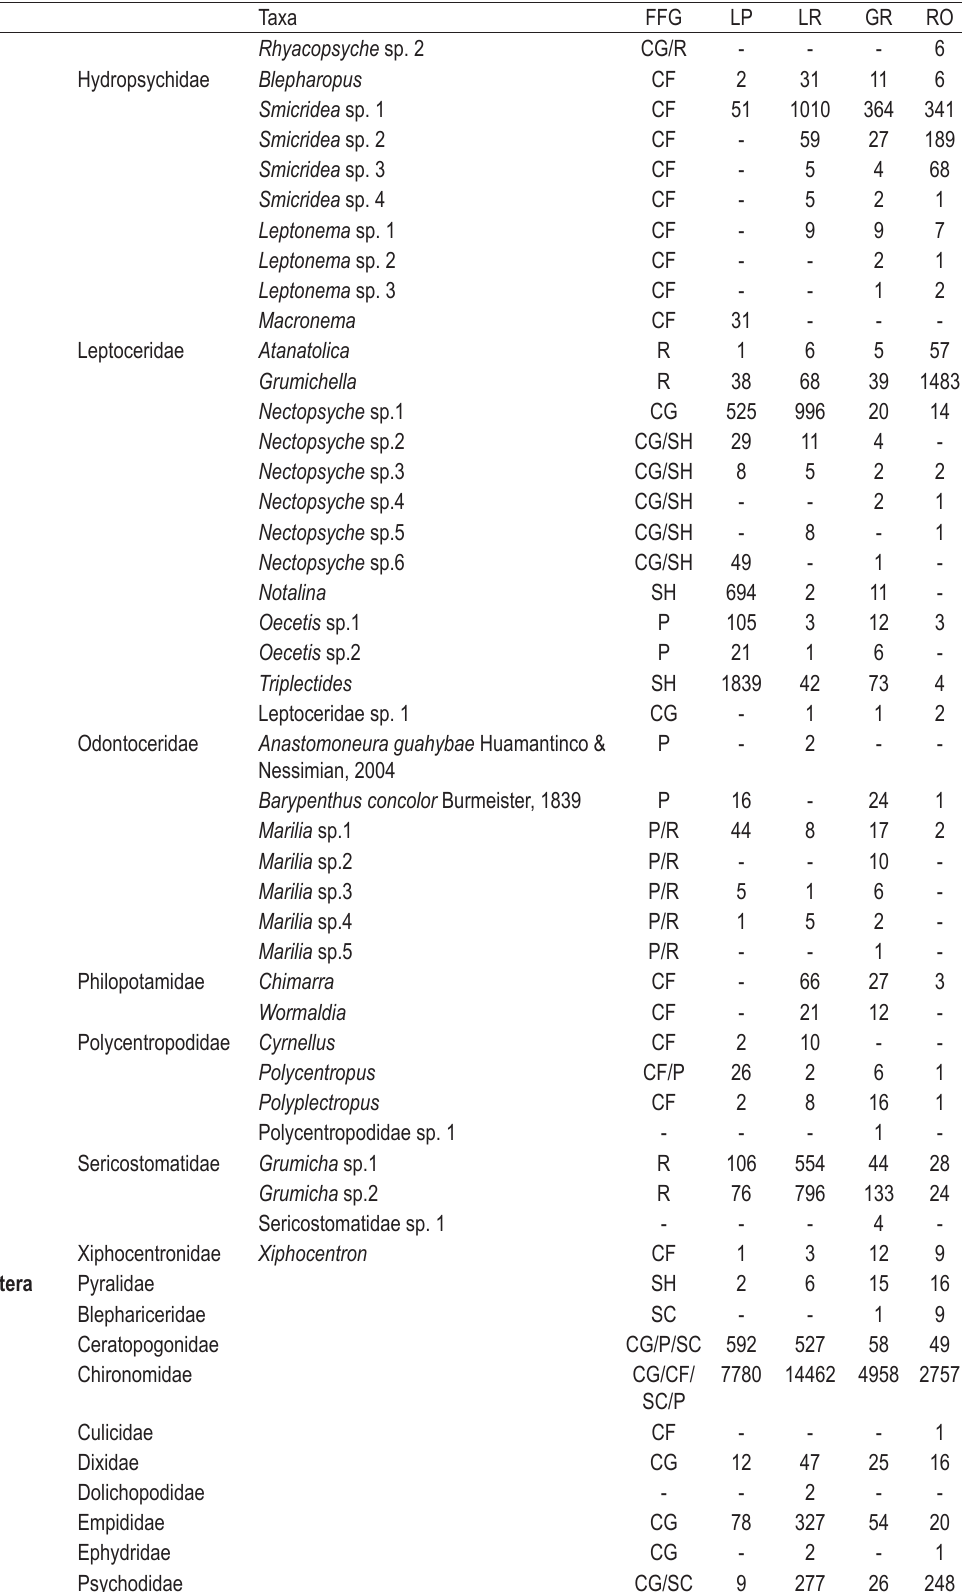
LP = litter from pool, LR = litter from riffle, GR = gravel and RO = rocks. CG = collector-gatherers, CF = collector- filterers, SC = scrapers, SH = shredders, P =